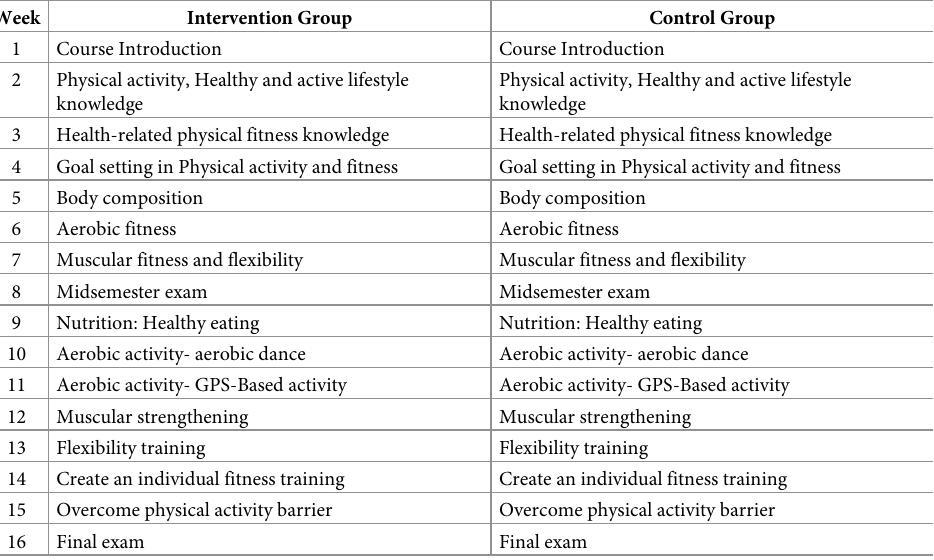
Table 1. Course content for intervention and control